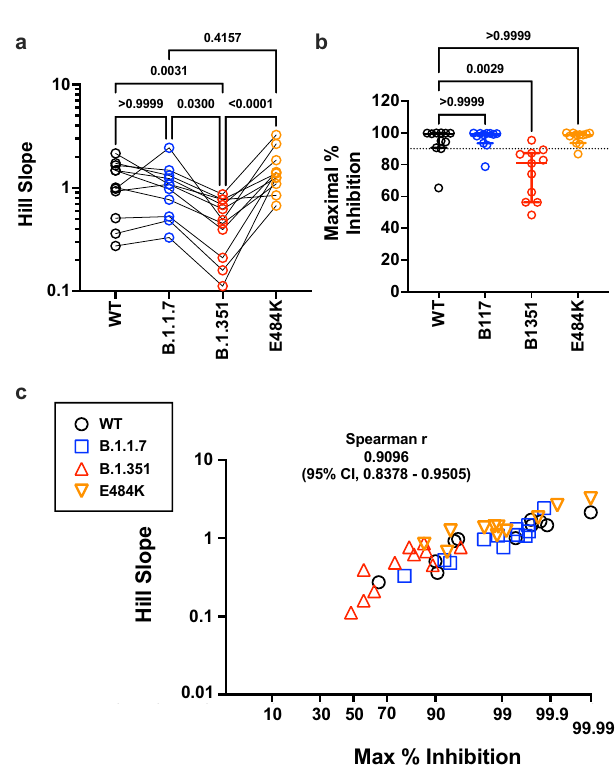
Fig. 4 Maximal inhibition and slope help to de fi ne the distinct classes of neutralizing sera in Sputnik vaccine recipients. a Paired comparison of Hillslopes from the neutralization curves of all samples except for SP012 where no signi fi cant neutralization was observed for viruses other than B.1.1.7. Adjusted p -values are indicated (non-parametric Friedman test with Dunn ’ s multiple comparisons test, which assumes non-Gaussian distribution of values being analyzed). b Maximal percent inhibition (MPI) at full serum strength extrapolated from nonlinear regression of log(inhibitor) versus normalized response, variable slope curve. Model used is from PRISM v9.1.1 where y ¼ 100 = 1 þ 10 ð log IC 50 (cid:2) x Þ ´ Hillslope . Log IC50 and Hill slope values were obtained for each curve generated in Fig. 3. MPI = 100 – Y , when X = 0 for reciprocal serum dilution of 1 (10 0 = 1). Data points for one serum (SP012) against WT, B.1.351 and E484K could not be calculated because there was no best- fi t value. The dotted line indicates 90% inhibition. Median (central bar) and interquartile values (whiskers) are indicated. Adjusted p -values was calculated as in a . Black, blue, red, and organe circles represent WT, B.1.1.7, B.1.351, and E484K viruses, respectively. c Correlation analysis of MPI versus the Hill Slope parameter for all sera samples tested against all spike proteins. SP012 was excluded for the abovementioned reasons. Non-parametric Spearman r -values and 95% con fi dence interval are shown. x -axis is plotted as an asymptotic cumulative probability scale as x approaches 100% (PRISM v9.1.1) only to resolve the many MPI values>90%. Source data are provided as a Source Data fi